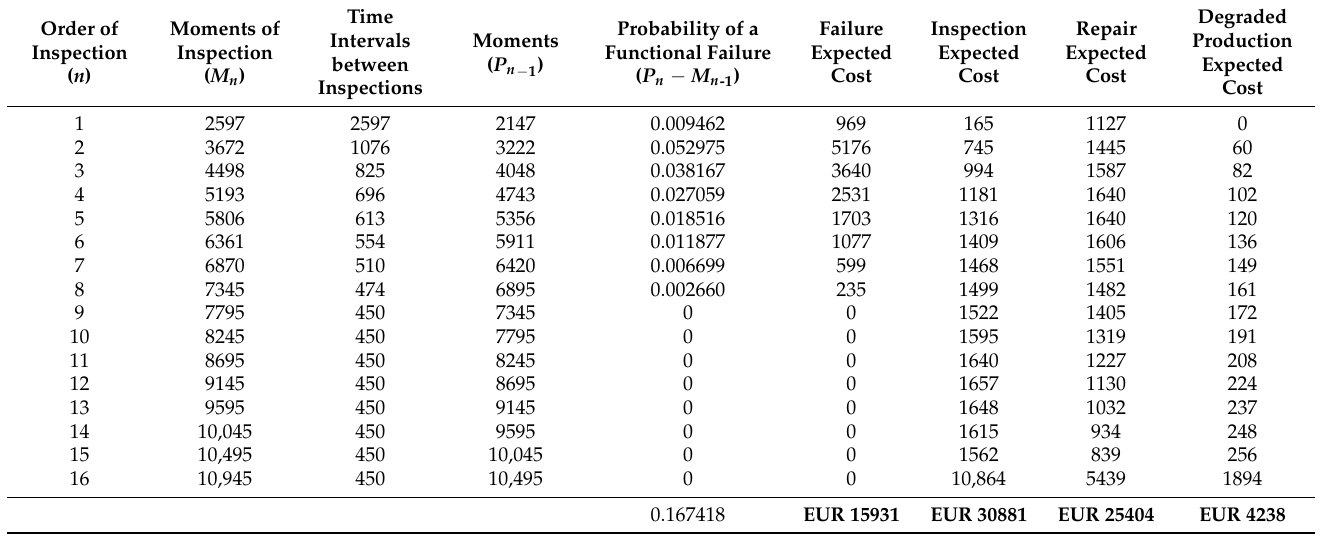
Table 1. Expected costs.